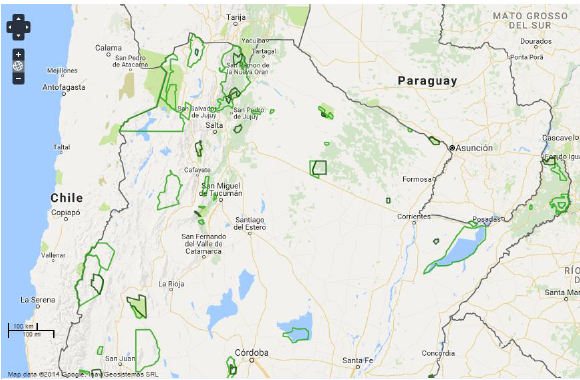
Figure 6. Protected Areas in the Provinces of Argentina that integrate the Andean Road System. © Instituto Geográfico Nacional, 2016. Base de Datos Geográfica. Visor SIG.